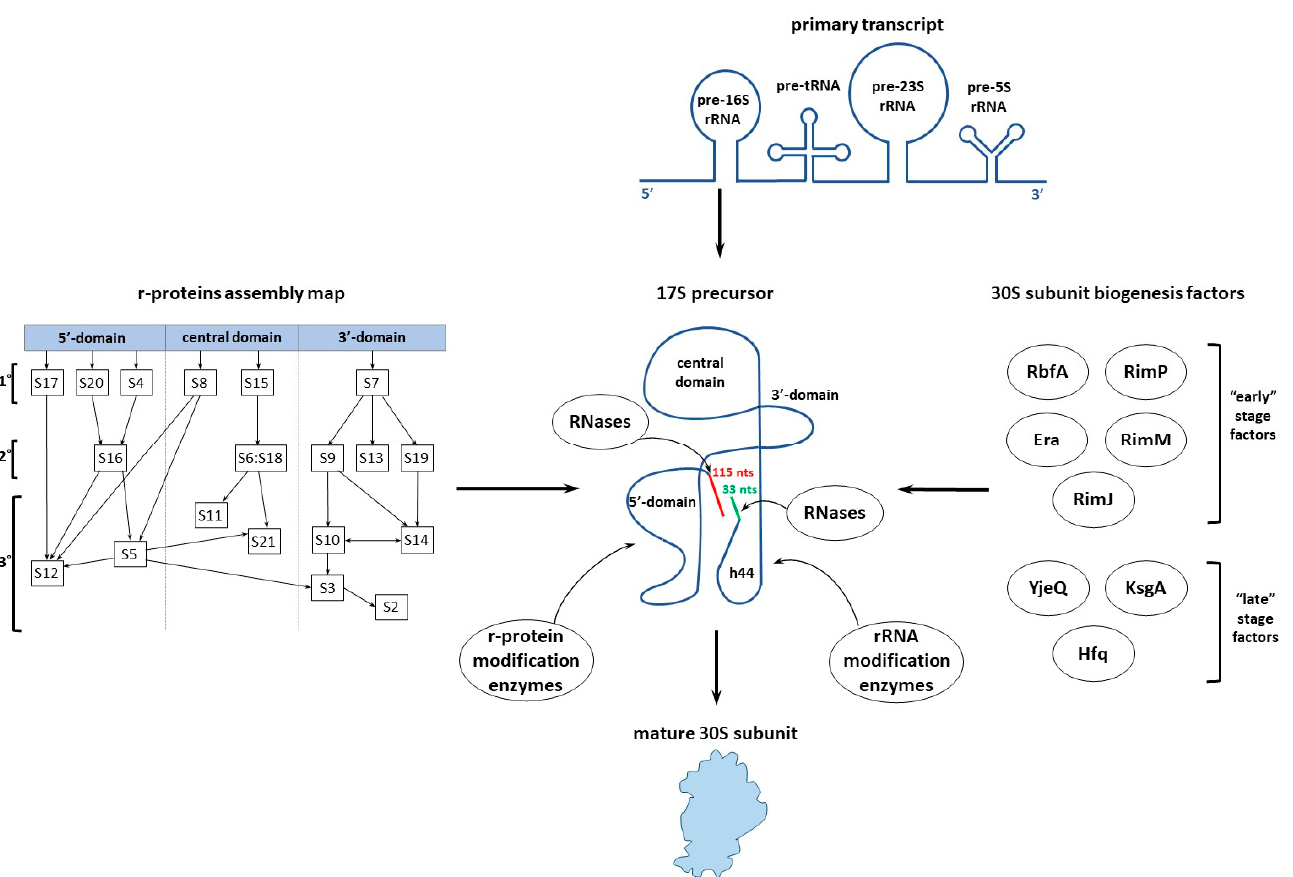
Figure 1. Main steps of the small ribosomal subunit (30S) assembly in bacteria. The steps are described in the main text in more detail. Hierarchical incorporation of the ribosomal proteins corresponds to Nomura assembly map [6]. Unprocessed 5 ′‐ and 3 ′‐ ends of the 17S rRNA are shown in red and green, respectively.